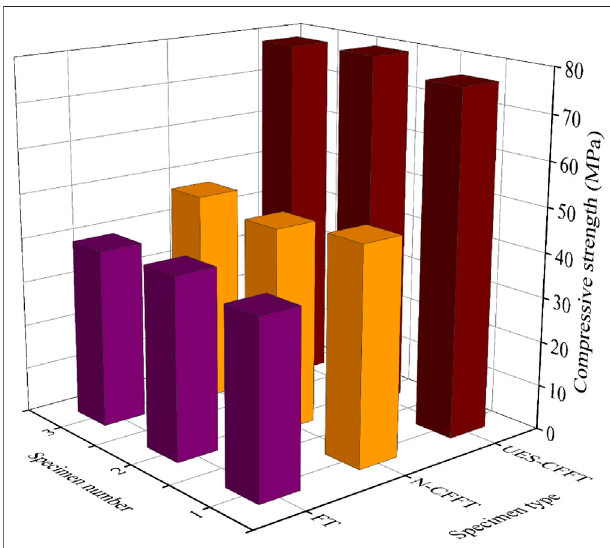
FIGURE 8 | Compressive strength comparison of the three types of specimens.